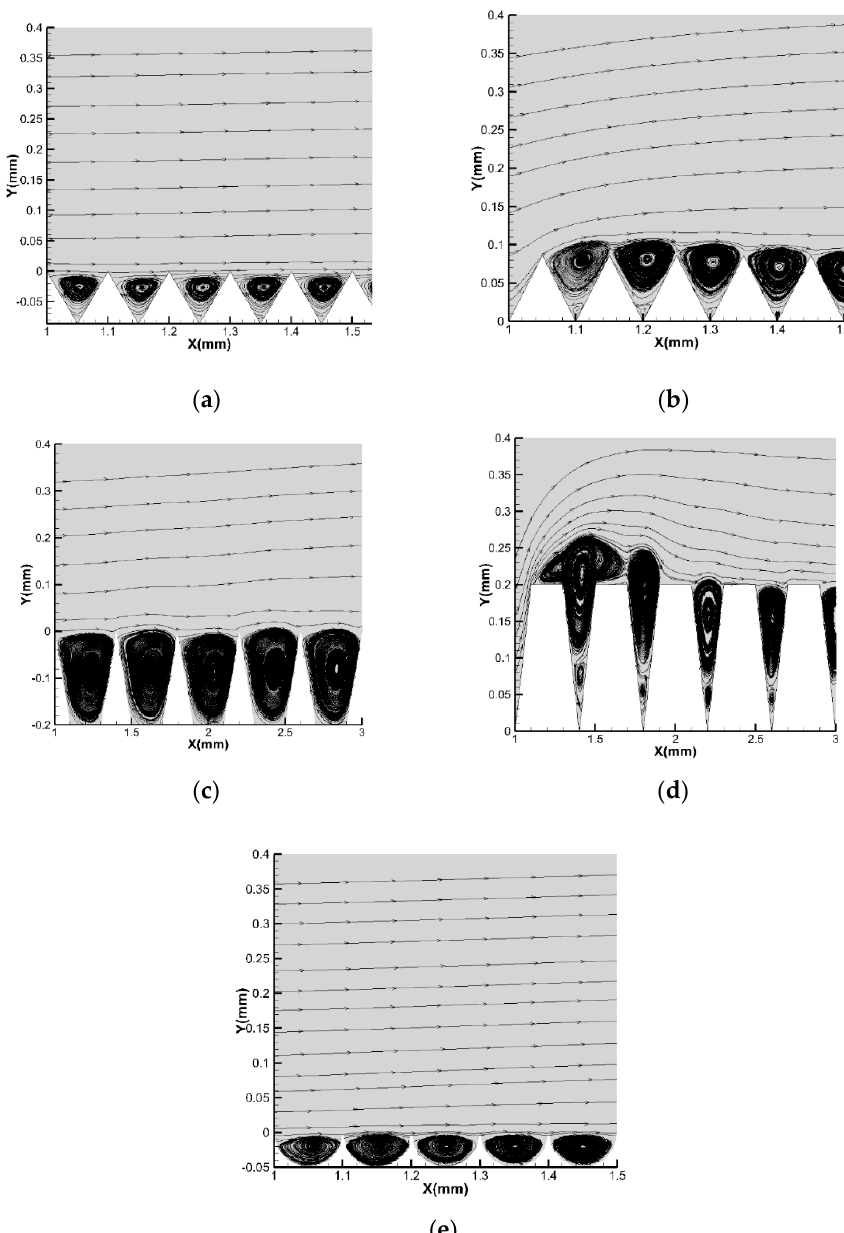
Figure 7. Streamlines of various plates at 0.5 Ma. ( a ) The triangular concave grooves, ( b ) the triangular protrusions, ( c ) the trapezoidal concave grooves, ( d ) the trapezoidal protrusions, and ( e ) the circular concave grooves.